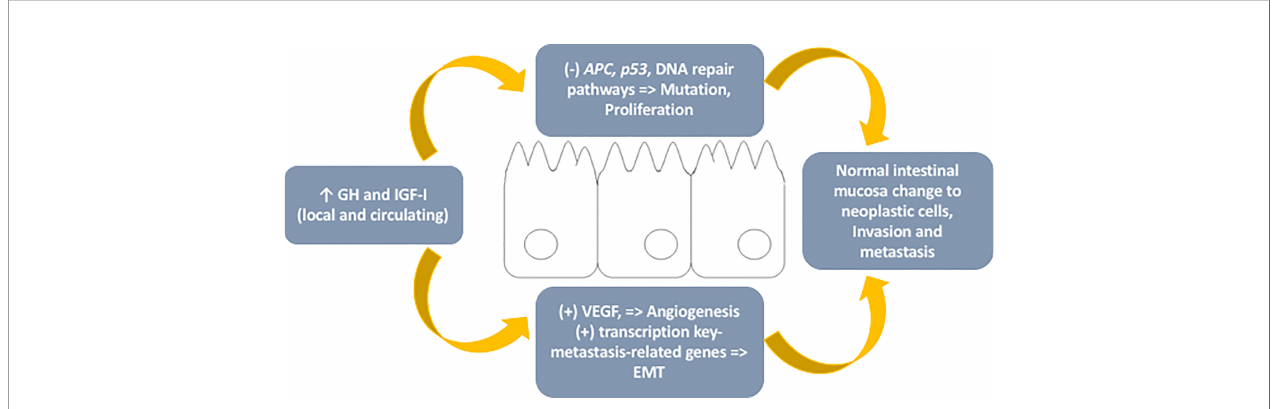
FIGURE 1 | – Schematic representation of mechanisms involved in the role of the GH-IGF-I axis in colorectal cancer. GH, growth hormone; IGF-I, insulin-like growth factor type I; APC, adenomatous polyposis coli gene; VEGF, vascular endothelial growth factor; EMT, epithelial-mesenchymal